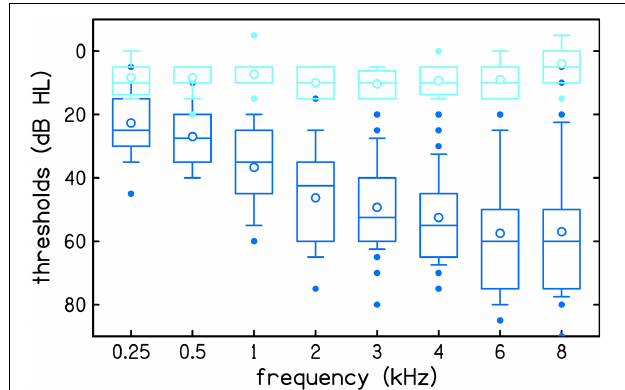
FIGURE 1 | Audiometric thresholds of 15 normal hearing participants (light blue) and 30 participants with hearing loss (dark blue). Boxes represent the interquartile range and whiskers represent the 10th and 90th percentiles. Outliers, defined as data points that are outside the 10th to 90th percentile range, are plotted using filled circles. Within each box, lines represent the median and open circles represent the